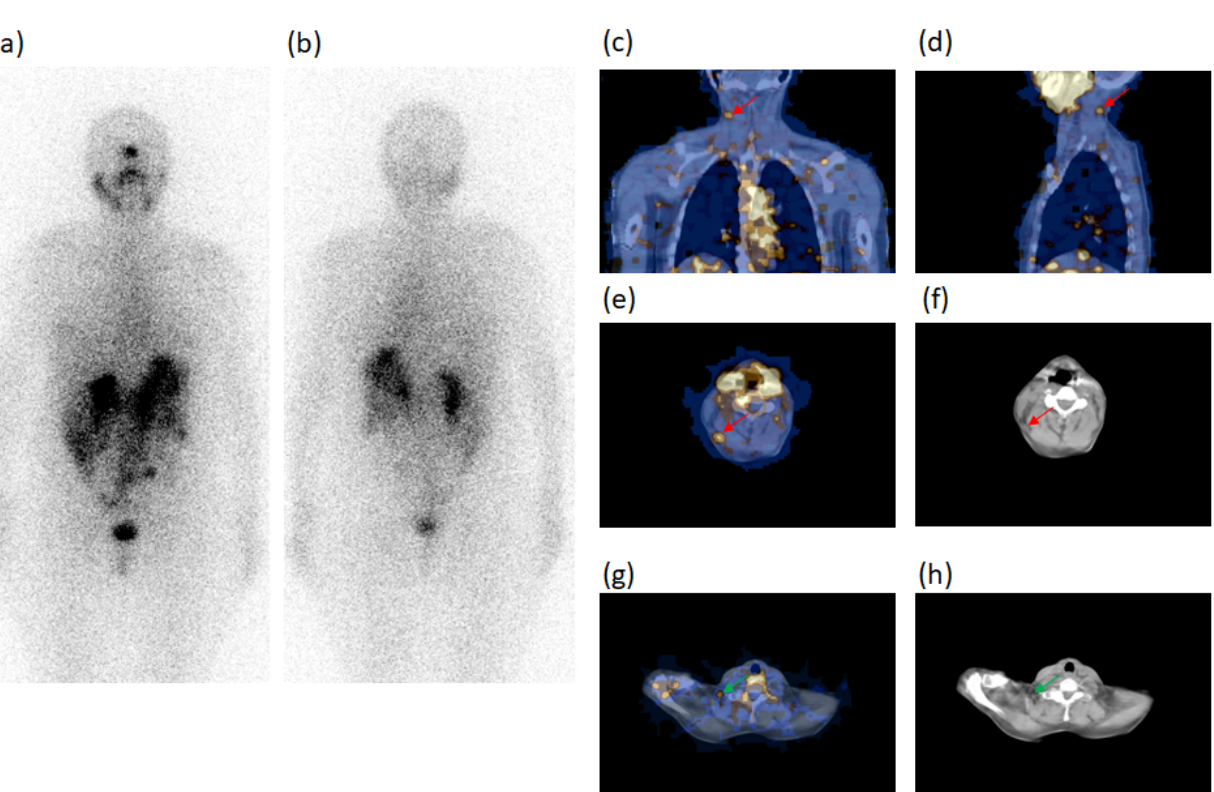
Figure 5. The same female patient described in Figure 4 (case n. 13, Table 4) was also evaluated during follow-up. 131 I-WBS after diagnostic dose of radioiodine in both anterior ( a ) and posterior ( b ) views did not evidence the residue foci ascertained at the exam performed after therapeutic dose and excluded the presence of other foci doubtful of malignant lesions. Fused SPECT/CT images in coronal ( c ), sagittal ( d ) and transaxial ( e ) slides did not evidence the two foci classified as residues at the previous exam during ablation. However, SPECT/CT identified two new foci, one in right laterocervical region ( e , red arrow) and the other in right supraclavicular region ( g , green arrow), both of these occult at WBS. These foci, confirmed at CT ( f , h ), were classified as lymph node metastases. The patient was treated with a radioiodine therapeutic dose again. Thyroglobulin levels in hypothyroidism condition: 13 ng/mL. AbTg: absent.